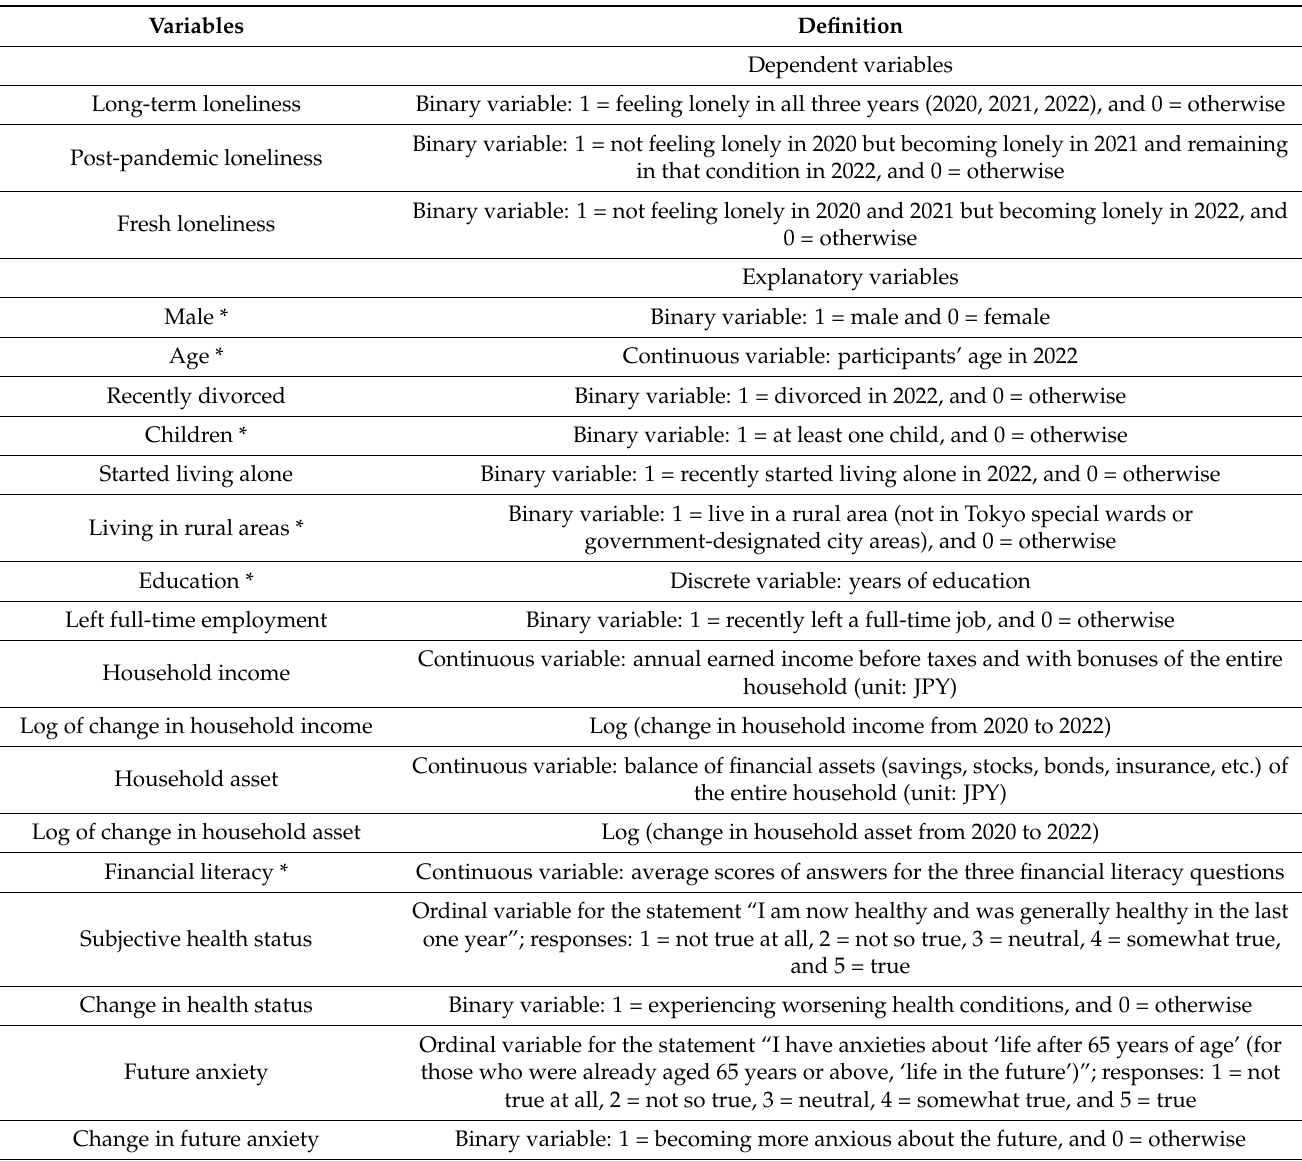
Table 1. Variable